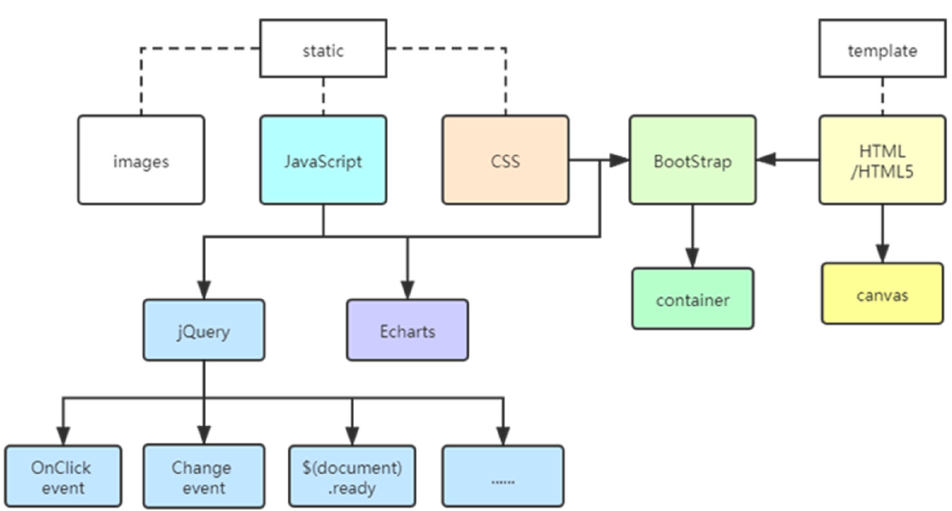
Figure 2. The web front-end architecture diagram.